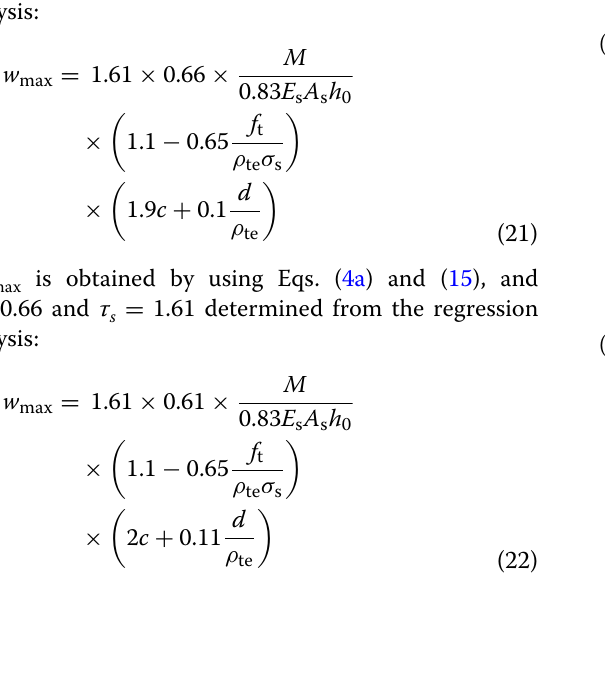
Table 11 Comparison results of w t max from RC beams with 500 MPa steel bars with w c1 max by the proposed methods. Data